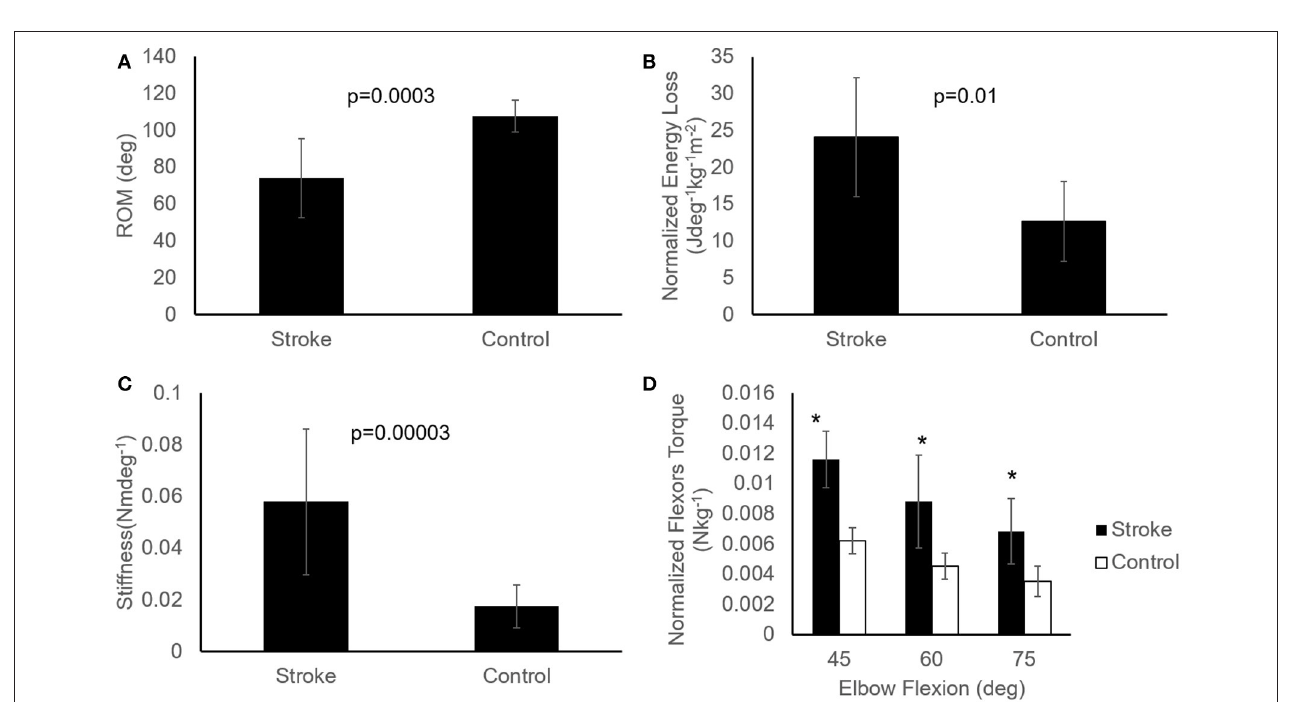
FIGURE 6 | Comparisons of passive properties of elbow flexors between the healthy controls ( n = 9) and stroke survivors ( n = 12). Patients post stroke showed reduced ROM (A) , higher energy loss (B) , increased stiffness (C) , and increased resistance torque at several angles (D) , represented as mean ± SE (standard error of mean). Asterisks (*) indicate significant difference ( p < 0.05) between the two groups (D) . Mann-Whitney U test with significance level of P < 0.05 was used to determine the